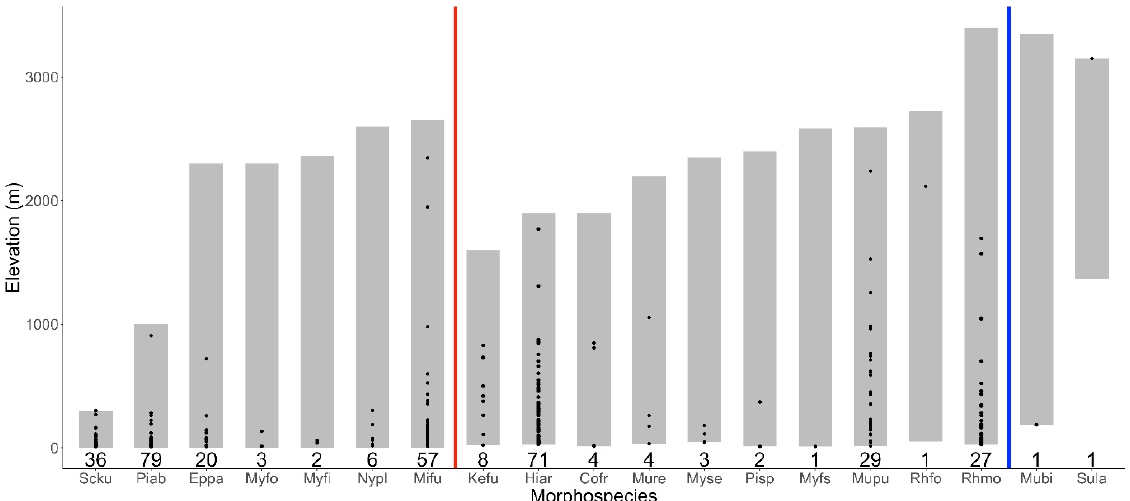
Figure 3. Elevational distribution of sample grids with roadkills (black solid circles) and elevational range of known species distribution (light gray bars) of each of the 19 victimized bat morphospecies in Taiwan. Red and blue vertical lines denote the lower limits of 0 m and 100 m in elevational distribution, respectively. Numbers underneath the gray bars denote number of grid samples for each morphospecies. Morphospecies abbreviations: Scku— Scotophilus kuhlii ,